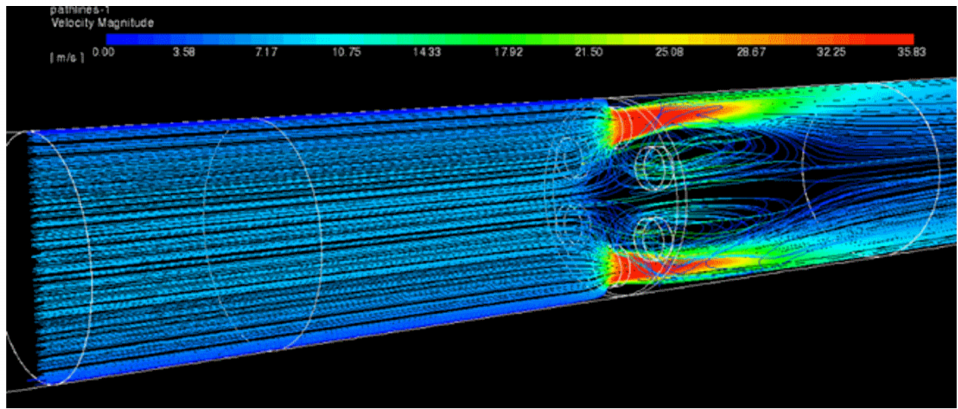
Figure 21. Streamlines for the reference case displayed on horizontal